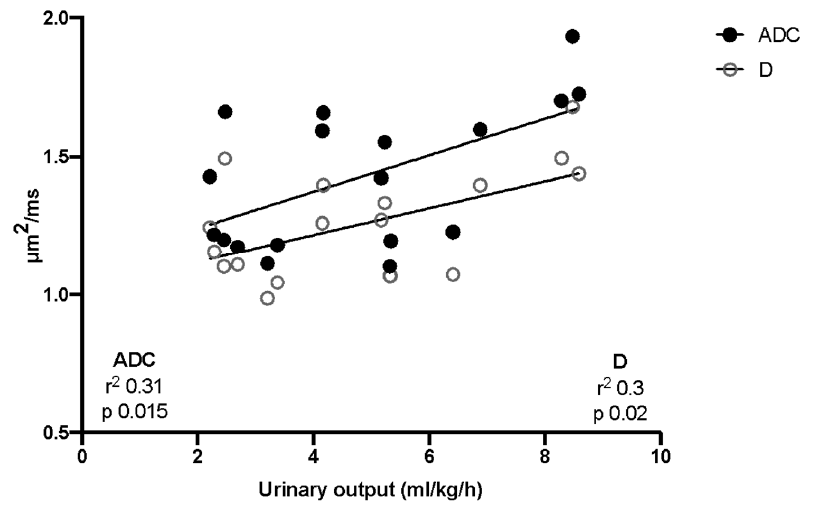
Figure 6. Correlation between ADC and urinary output. All the groups are plotted together.